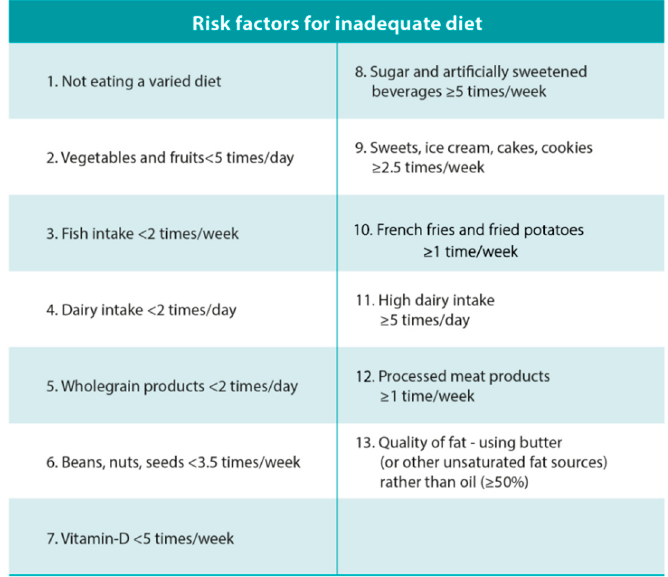
Figure 1. The predefined dietary risk factors for inadequate diet. The risk factors were mainly based on the Nordic Nutrition Recommendations [19] and the Icelandic Food-Based Dietary Recommendations [20]. If the women excluded/avoided any of the main food groups (cereal, vegetables/fruits, fish, meat, eggs, high-fat foods or dairy), they were categorized to the group of not eating a varied